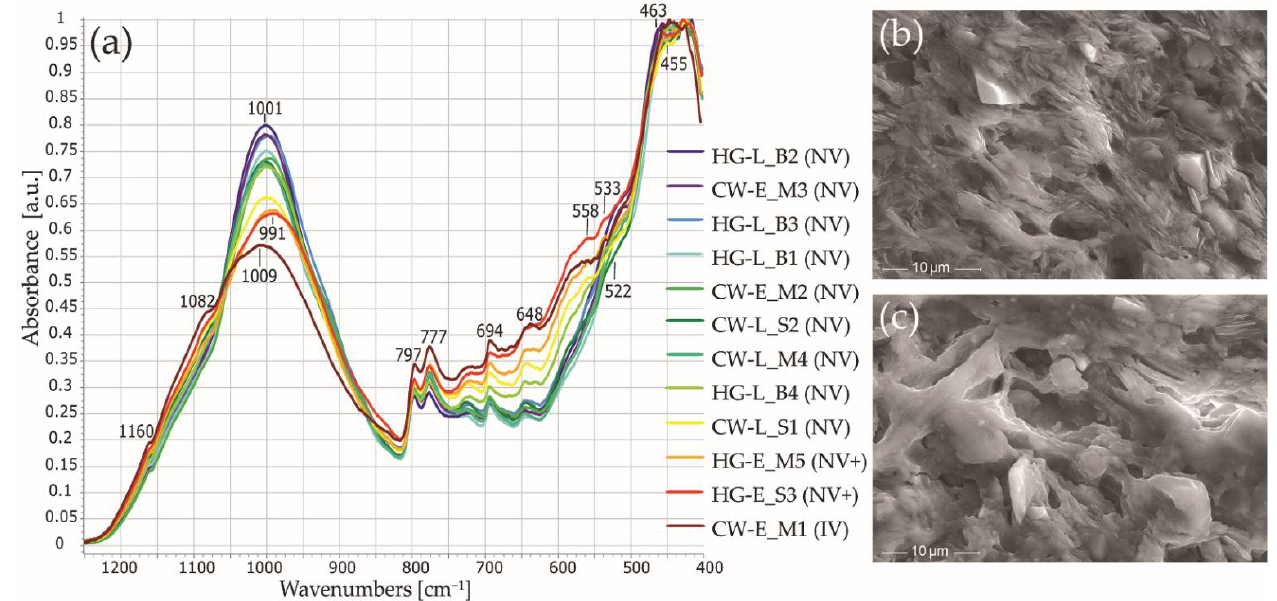
Figure 11. Firing temperature-related microstructural differences in the studied samples. ( a ) Normalized FTIR absorbance spectra for the studied samples in the 1250–400 cm −1 range. The intensity of the main Si–O stretching band decreases and microstructural vitrification changes appear as the firing temperature increases. ( b ) SEM SE image of a non-vitrified structure in HG-L_B2. ( c ) SEM SE image of an initial vitrification structure in CW-E_M1. Abbreviations: NV—no vitrification; NV+—the intermediate stage between NV and IV; IV—initial vitrification.